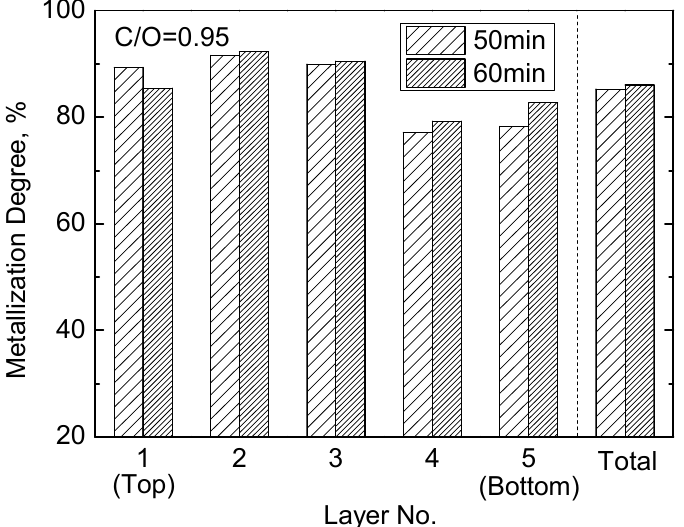
Figure 11. Effect of reduction time (50 min and 60 min) on the metallization degree of direct reduced iron (DRI).